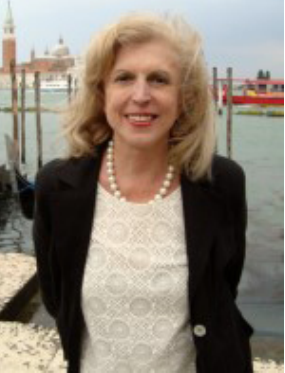
Figure 5. Paola Malanotte-Rizzoli (source: IAPSO